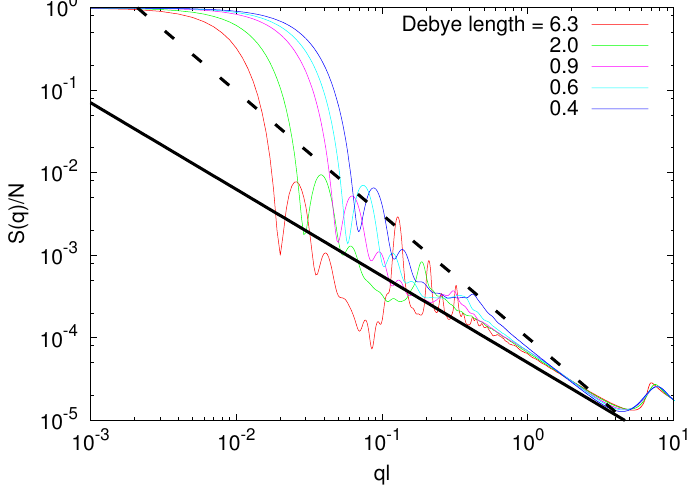
Figure 7. Spherically averaged static structure factors S ( q ) for N l /l = 5 and l /l = 0 . 4 − 6 . 3 . The solid line is proportional to q − 1 . 05 and the dashed B D line to q − 1 / 0 . 67